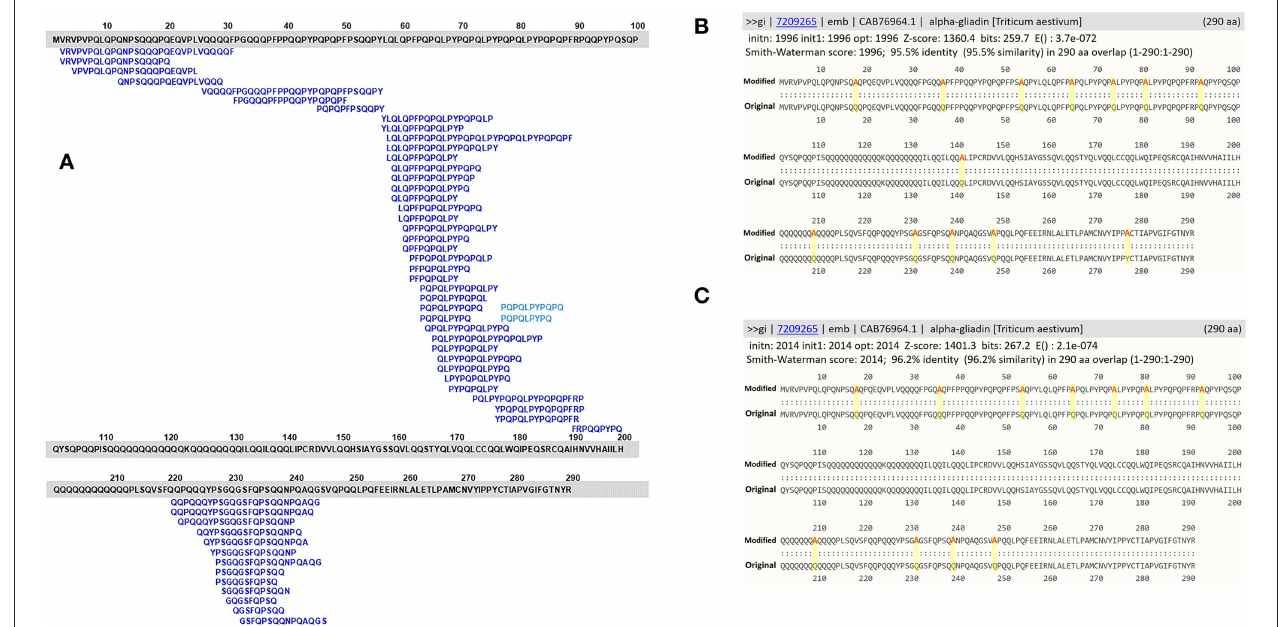
FIGURE 2 | (A) Amino acid sequence alignments of an α -gliadin (NCBI accession number: CAB76964) with 53 overlapping CeD-associated peptides identified with the exact sequence match tool; (B) full FASTA sequence alignment results with homology scores of the α -gliadin theoretically substituted with 13 alanine residues; (C) full FASTA sequence alignment results with homology scores of the α -gliadin theoretically substituted with 11 alanine residues.